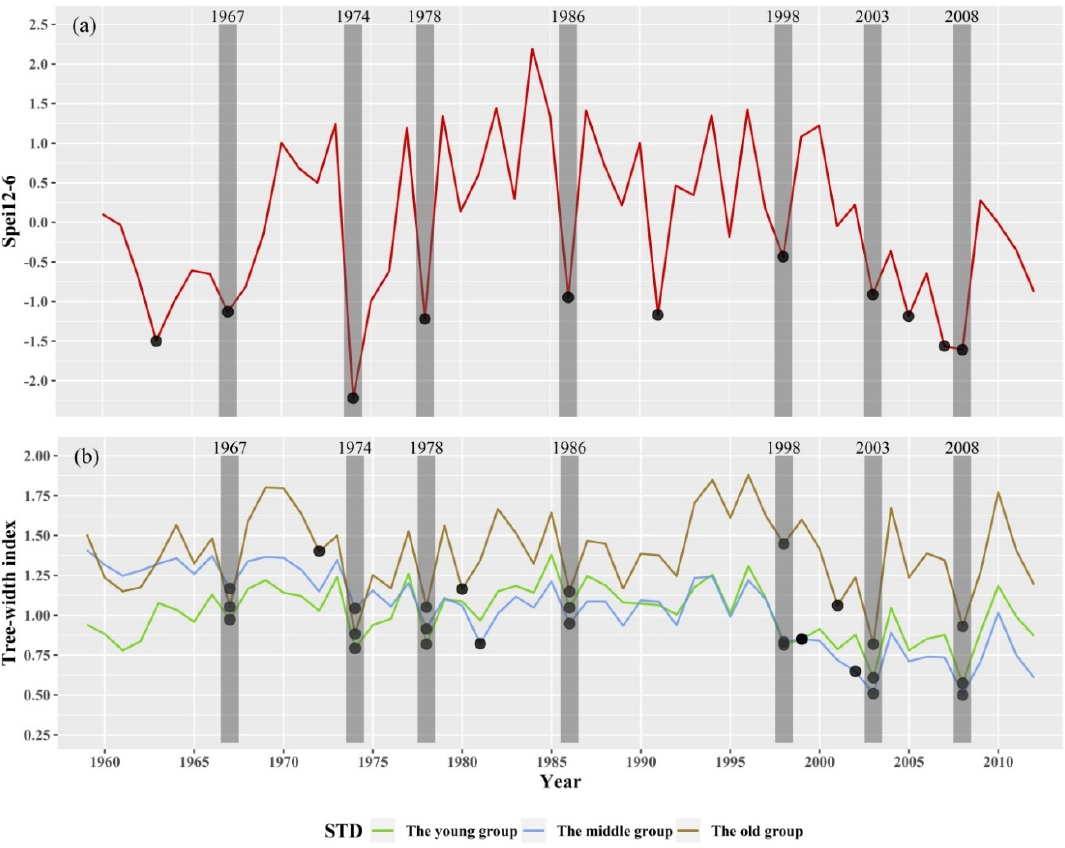
Figure 6. Inter-annual variability of the standardized precipitation evapotranspiration index ( SPEI ) values in June with a 12-month scale ( a ) and tree-ring width chronologies of the three Schrenk spruce age groups ( b ). The black dots indicate the selected pointer years; the rectangular shadings indicate the common pointer years of the SPEI and chronologies.